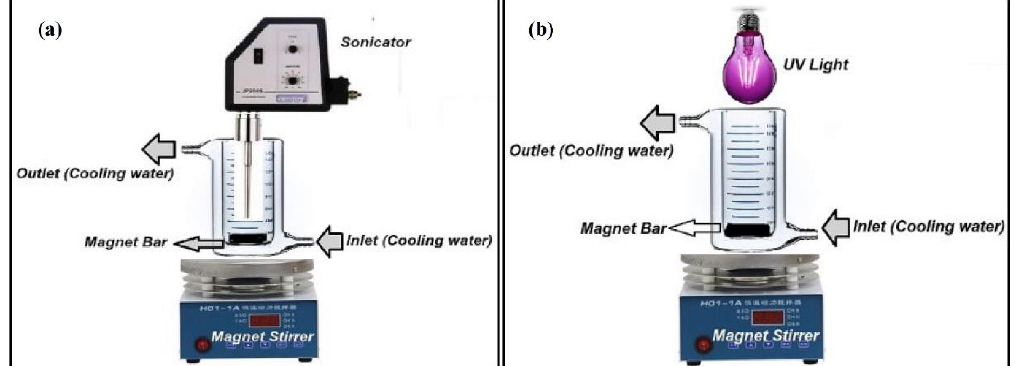
Fig. 1. Schematic of reactor: a) Sono-reactor, b) Photo-reactor